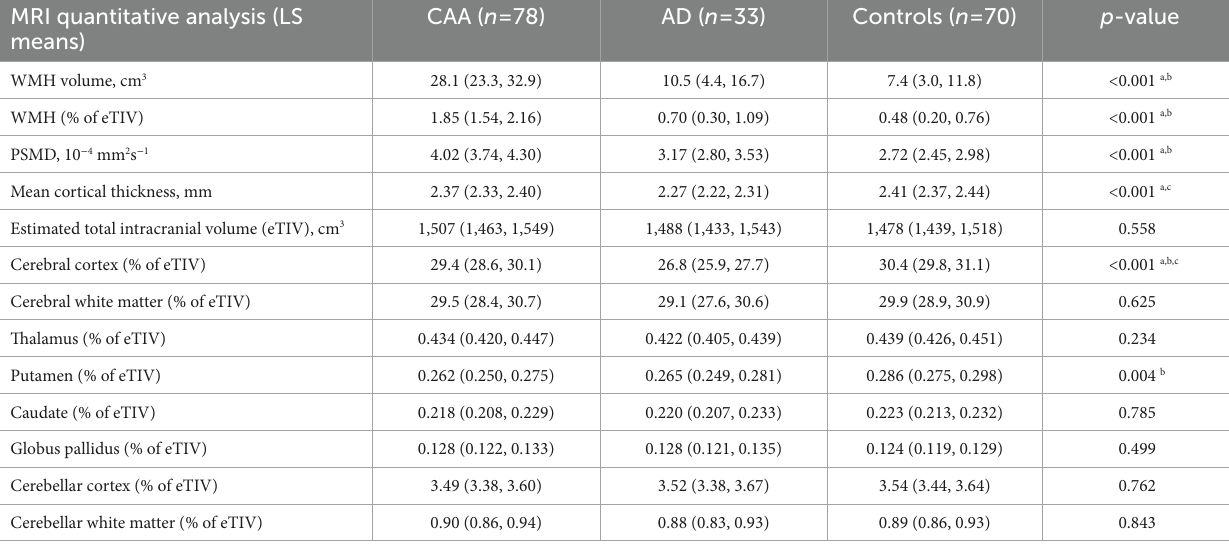
TABLE 3 Summary of quantitative MRI markers expressed as age-, sex-, and study site- adjusted least square means (95% confidence intervals). MRI quantitative analysis (LS means)